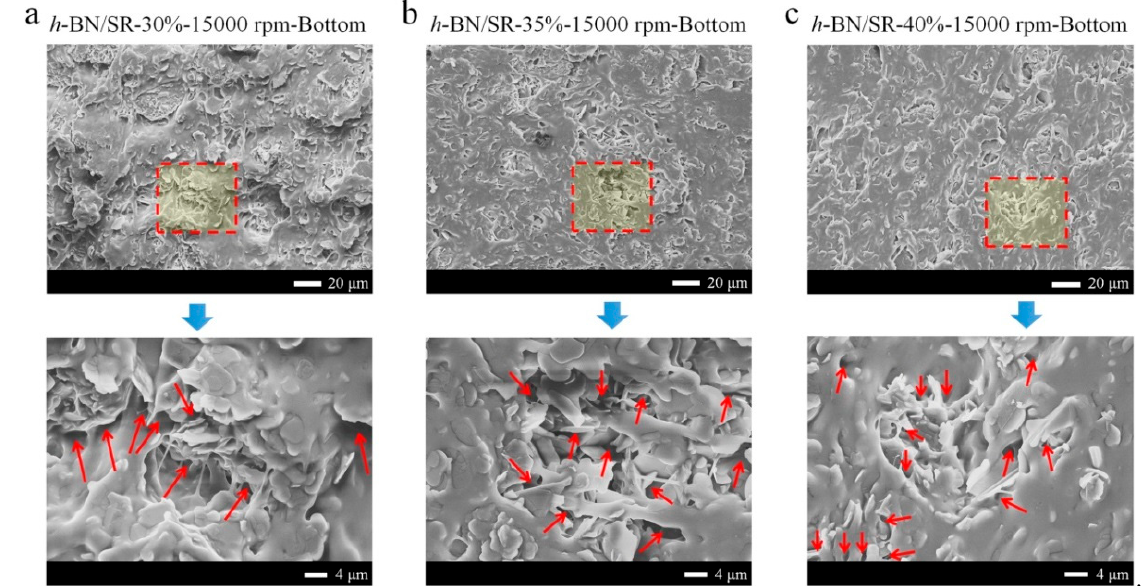
Figure 5. ( a – c ) SEM images of the cross ‐ sections of h ‐ BN/SR composites prepared with hypergravity treatments. Many micro ‐ cracks (red arrows) can be seen between h ‐ BN sheets.